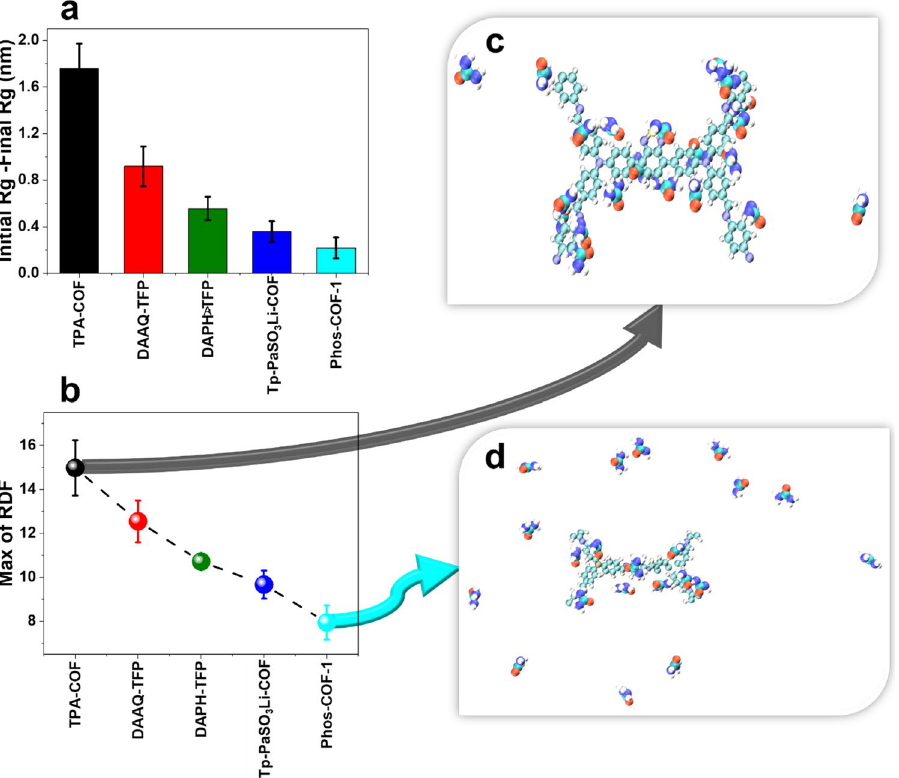
Figure 3. ( a ) The difference between initial and final gyration radius ( b ) Max RDF values for each system (c ) TPA-COF nanoparticles with highest max of RDF ( d ) PhOS-COF-1 nanoparticles with lowest max of